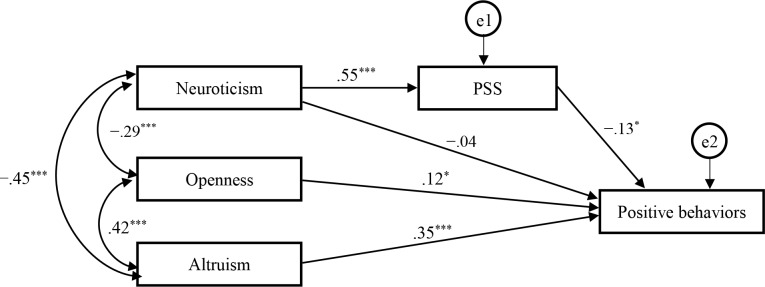
Final path model for personality traits, global stress and positive pedestrian behaviors.Path coefficients are standardized regression coefficients. *
p < .05 (two-tailed), *** p < .001 (two-tailed).